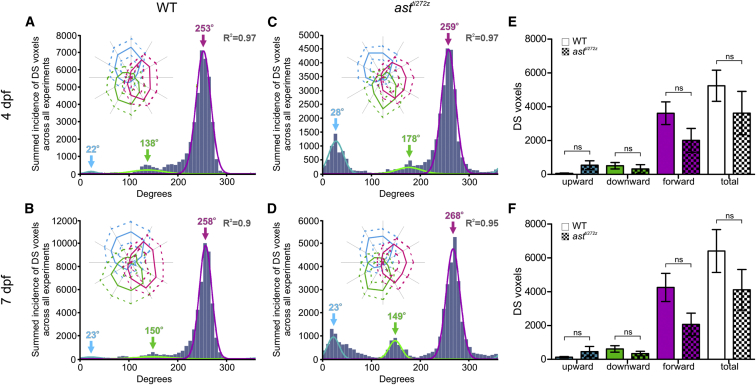
Tuning of DS-RGCs Innervating the Tectum Is Normal in astray MutantsFunctional imaging in WT (n = 8, total of 24 optical sections) and astti272z (n = 9, total of 27 optical sections) larvae expressing the presynaptic reporter of neural activity, SyGCaMP3, specifically in RGC axons (Tg(Isl2b:Gal4;UAS:SyGCaMP3)).(A–D) Cumulative histograms summarizing the incidence of preferred angles of all DS voxels in WT larvae at 4 dpf (A) and 7 dpf (B), and astti272z larvae at 4 dpf (C) and 7 dpf (D). Overlaid colored curves show fitted von-Mises distributions used to identify three functional subtypes of DS-RGC. Color-coded arrows represent peak preferred angles of each subtype. R2 values relate to the summed von-Mises distributions. Insets show polar plots of the mean (solid line) ± 1 SD (dashed line) normalized response profile for voxels of each DS-RGC subtype.(E and F) Quantification of DS voxel numbers shows no significant difference between WT and astti272z RGCs at 4 dpf (E) or 7 dpf (F). All graphs show mean values ± SEM. ns, not significant, unpaired t test. See also Figure S1, Table S1, Movies S1 and S2.